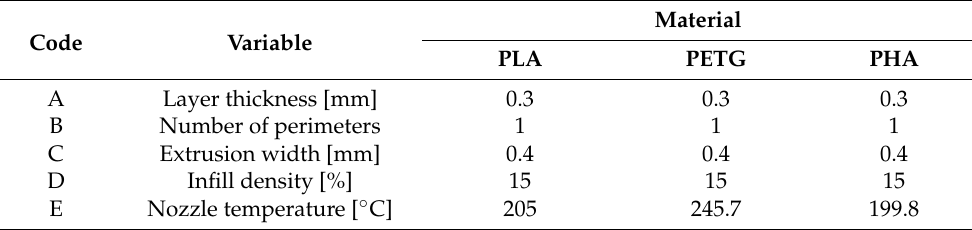
Figure 9. Optimization according to sustainability (CO 2 -eq) and filament price (EUR) for PHA material. Table 7. Optimal values of 3D printer setup according to sustainability and filament price.